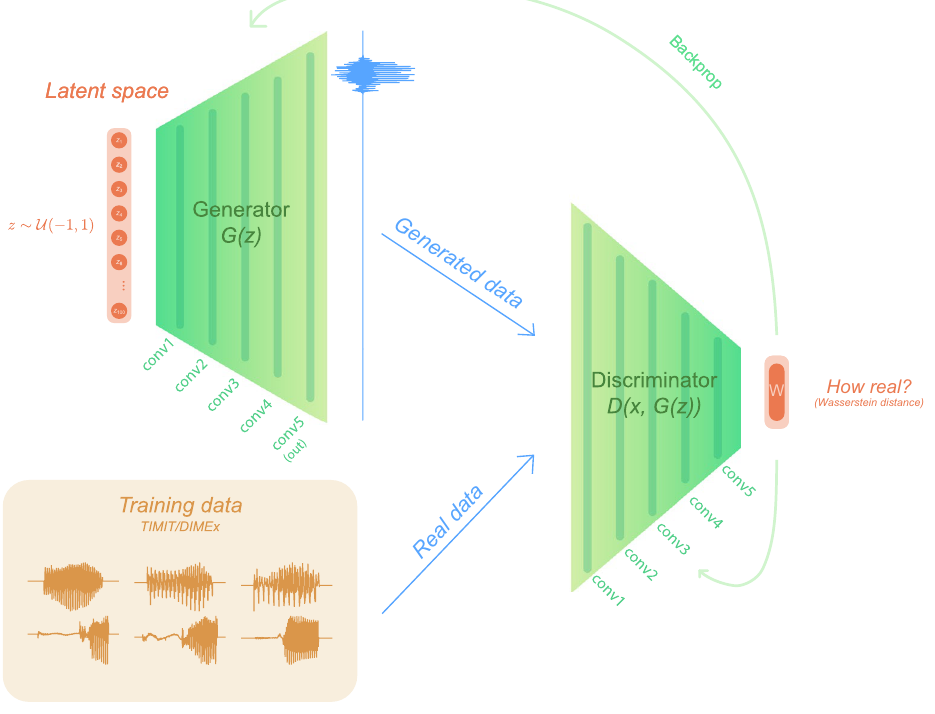
Figure 2. WaveGAN architecture 66 (based on DCGAN 67 ) used in training. The training data were taken from TIMIT and DIMEx as described in the “Data”